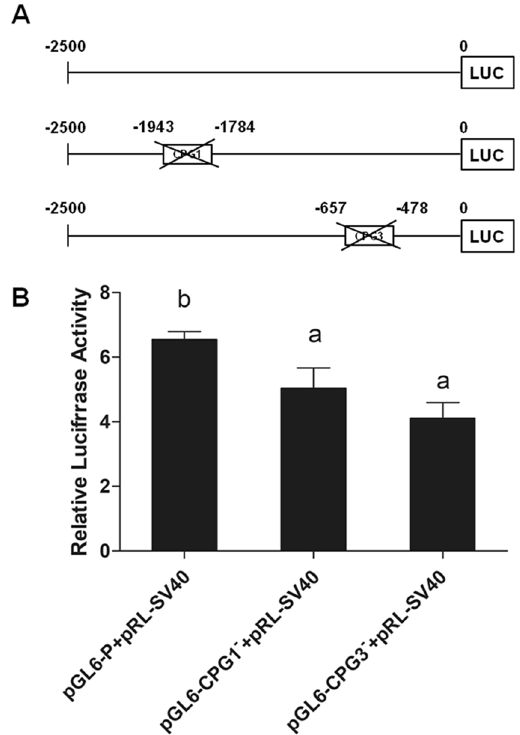
Figure 10. Relative activity of the upstream regulatory region of T1R1 gene. ( A ) Schematic representation of the upstream regulatory region of T1R1 gene. A series of plasmids containing the upstream sequences of grass carp T1R1 of different lengths (PGL6-T1R1-P, PGL6-T1R1-CPG1 − , PGL6-T1R1-CPG3 − ) fused in the frame to the luciferase were co-transfected with pRL-SV40 into HEK293T cells. ( B ) Relative activity of the upstream regulatory region of T1R1 gene with deletions. Values were normalized to the control plasmid pGL6-Basic and represented as the ratio between firefly and Renilla luciferase activities. The results are expressed as the mean ± SEM arbitrary units of three independent experiments ( P <